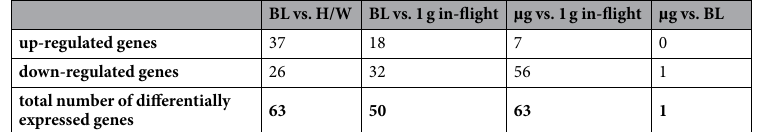
Table 8. Differentially expressed annotated genes in T cells during the TEXUS-51 mission. Number of annotated significantly differentially expressed genes that are included in only one comparison after elimination of differentially expressed genes due to hardware effects (hardware 1 g ground control compared to the cell culture control) and 1 g in-flight effects (1 g in-flight control compared to the hardware 1 g ground control).